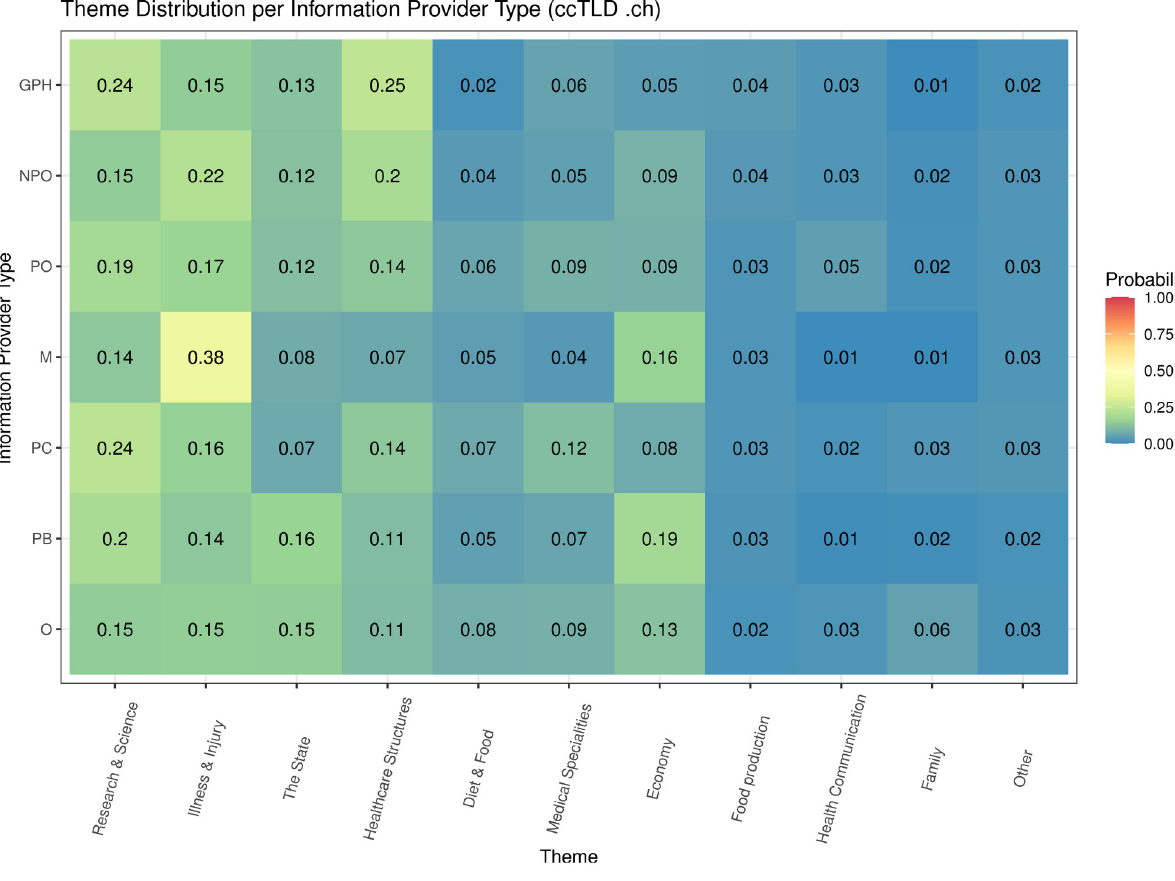
Fig 11. Theme distribution per information provider type for the ccTLD “.ch”. Information provider types: GPH: Government, Public Institution or Public Health, NPO: Non-Profit Organization, PO: Private Organization, M: Mainstream or Local News, PC: Pharmaceutical Company, PB: Private Blog, Other: